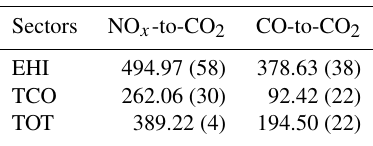
Table 2. The NO x -to-CO 2 (gCO 2 [gNO 2 ] − 1 ) and CO-to-CO 2 (gCO 2 [g CO] − 1 ) emission conversion factors based on the EDGAR v4.2 emission inventory along with their relative uncer- tainties given in brackets as one-sided 68.3% confidence interval (in %).